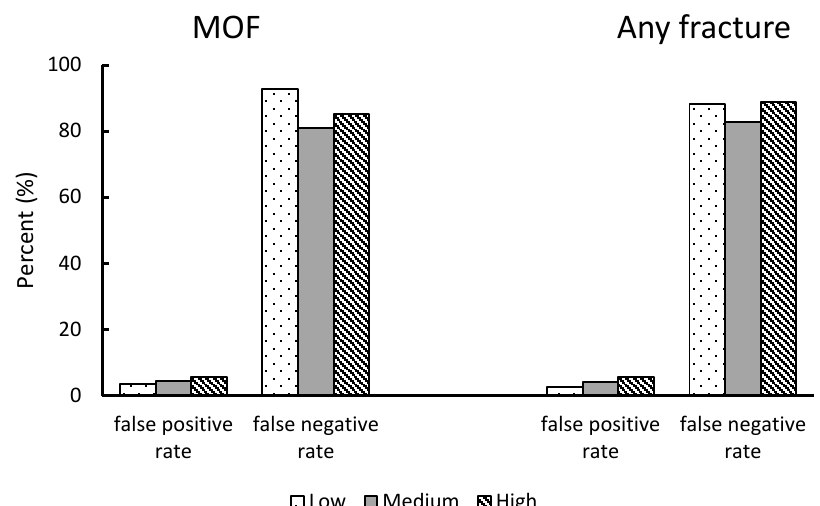
Figure A3. False-positive rate and false-negative rate for major osteoporotic fracture and any fracture in the analytic sample by polygenic score group, 10 years of follow-up.